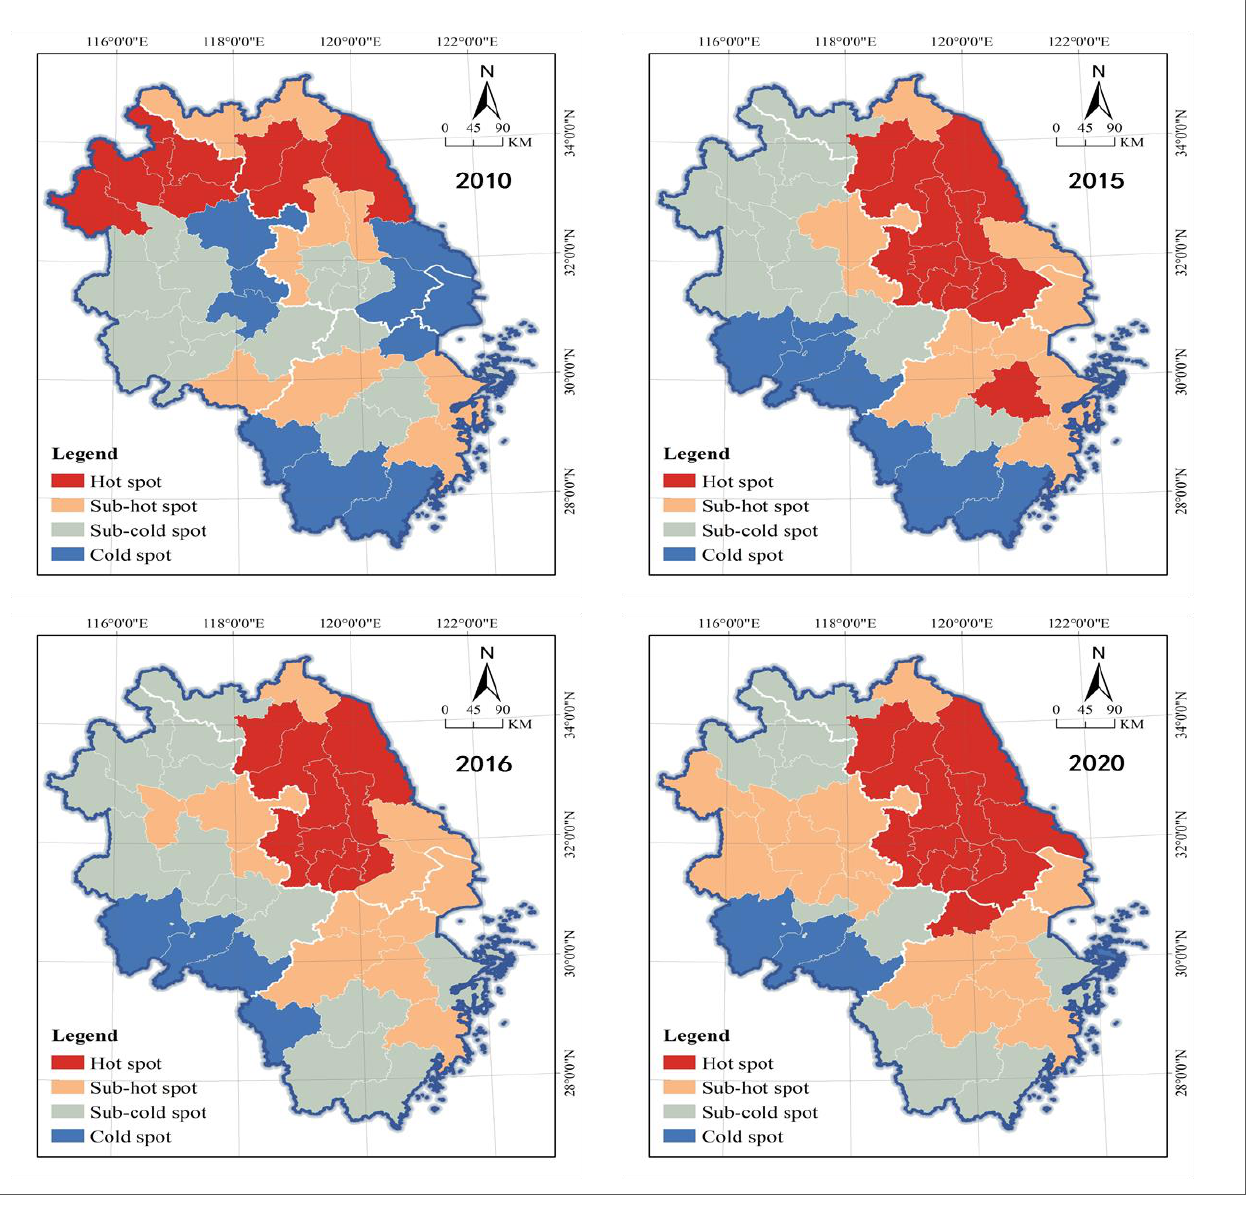
Figure 10. Analysis on the hot and cold area of scale efficiency in Yangtze River Delta.